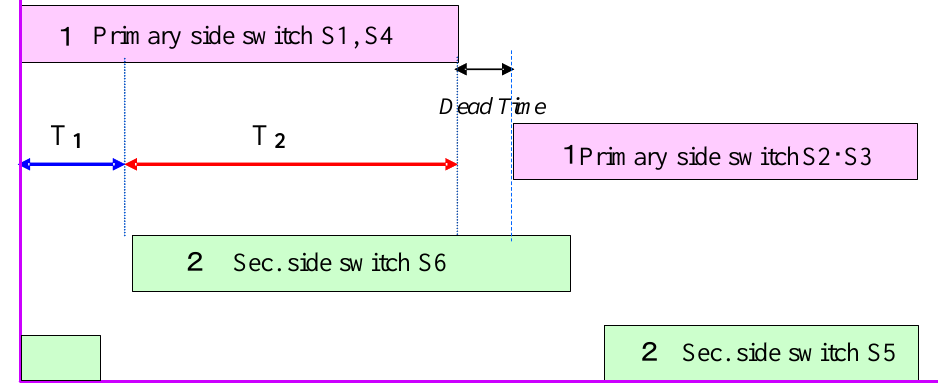
Figure 3. Pulse timing of the voltage signal of each switch.